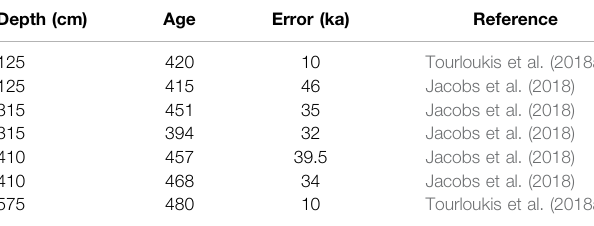
TABLE 2 | Overview of input ages of MAR-1 age model. Depth